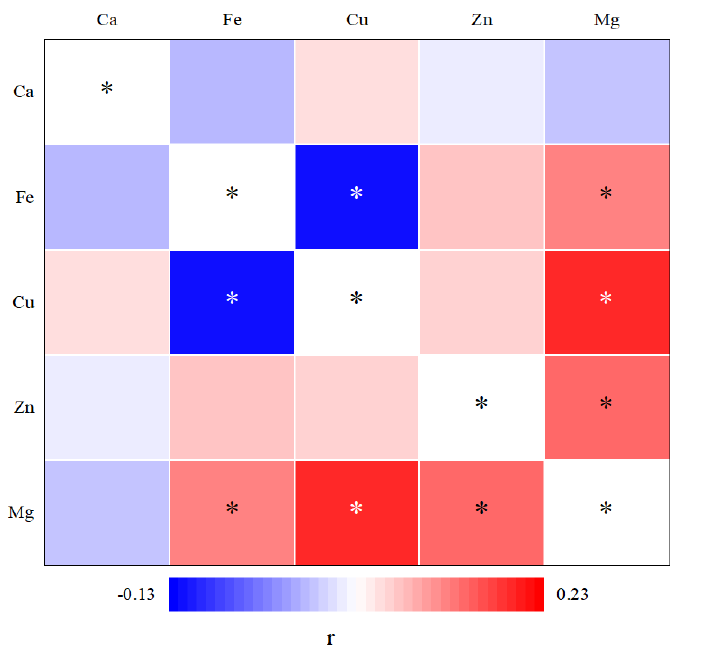
0.091 a Adjustment: age and sex. b The p − value was adjusted using false discovery rate method for multi- ple testing. Abbreviations: SFAs—saturated fatty acids; MUFAs—monounsaturated fatty acids; PUFAs—polyunsaturated fatty acids.